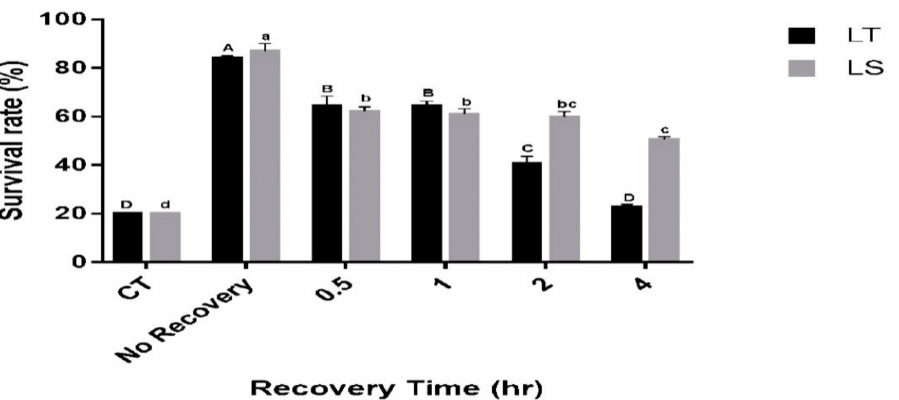
Figure 3. Mean survival of L. trifolii and L. sativae pupae in experiments for RCH durability. RCH- exposed pupae were either transferred directly (no recovery) or incubated for 0.5, 1, 2 or 4 h at 26 ◦ C and then transferred to the critical temperature for 2 h (CT: Lt, − 10.6 ◦ C, Ls, − 8.9 ◦ C). Survival was determined after pupal emergence. Different letters indicate significant differences. Uppercase and lowercase letters represent L. trifolii and L. sativae , respectively. Abbreviations: LT, L. trifolii ; LS, L. sativae ; and CT, critical temperature.